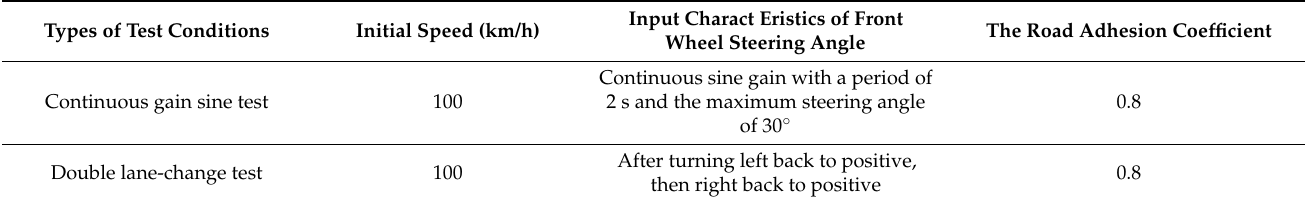
Table 12. Setting of test conditions.